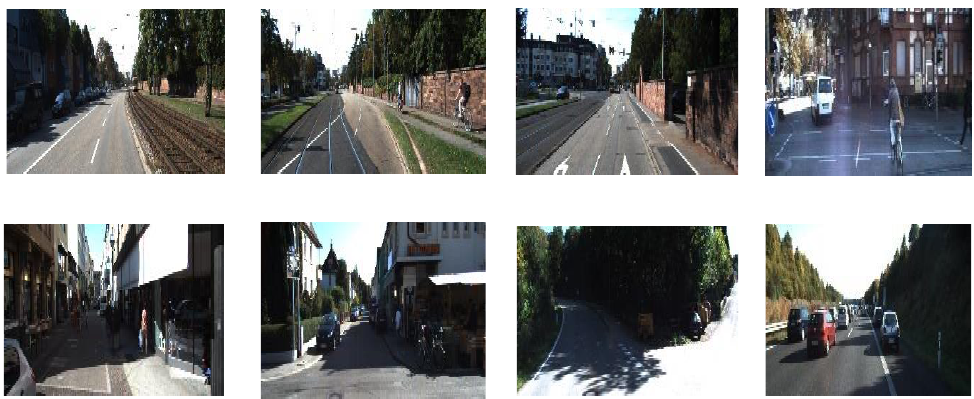
Figure 5. Partial images of